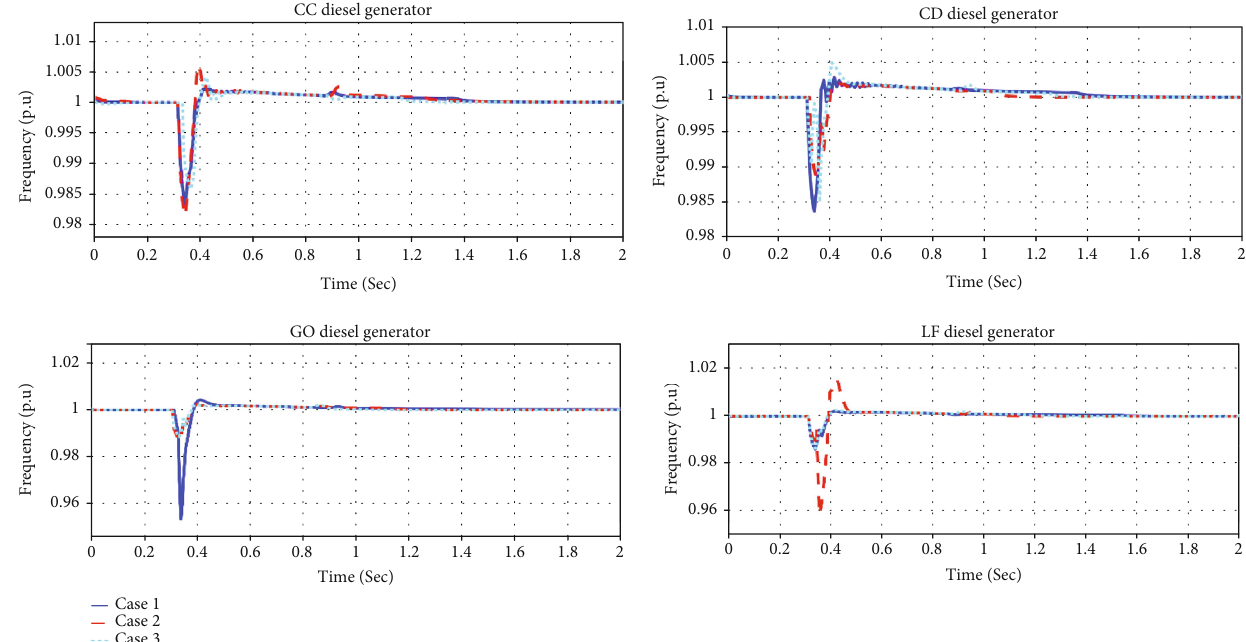
Figure 10: Frequency responses for diesel generator module for the four strategies. This fi gure is reproduced from Shezan et al. [5].